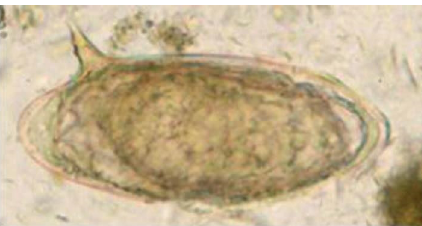
Figure 2: Egg of Schistosoma bovis (oval to spindle-shaped with centrally bulged and terminal spines on one side of an